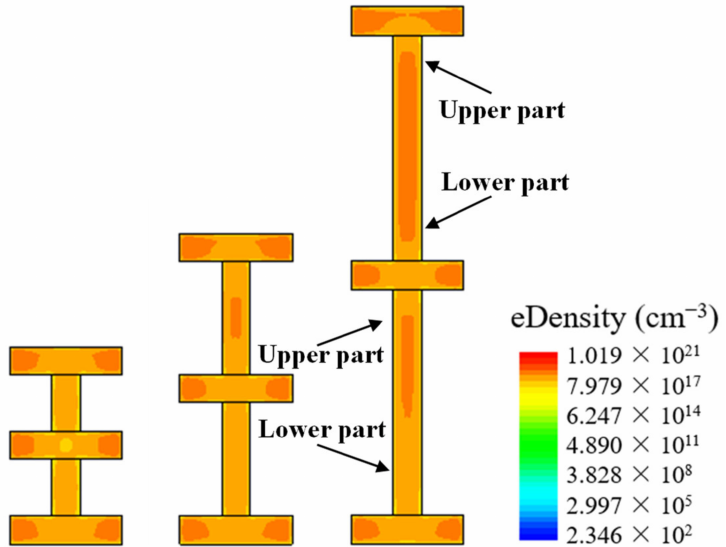
Figure 8. Electron density of channel cross sections with S NS = 10/20/40 nm (from left to right) at W IB = 5 nm at V GS = V DS = 0.7